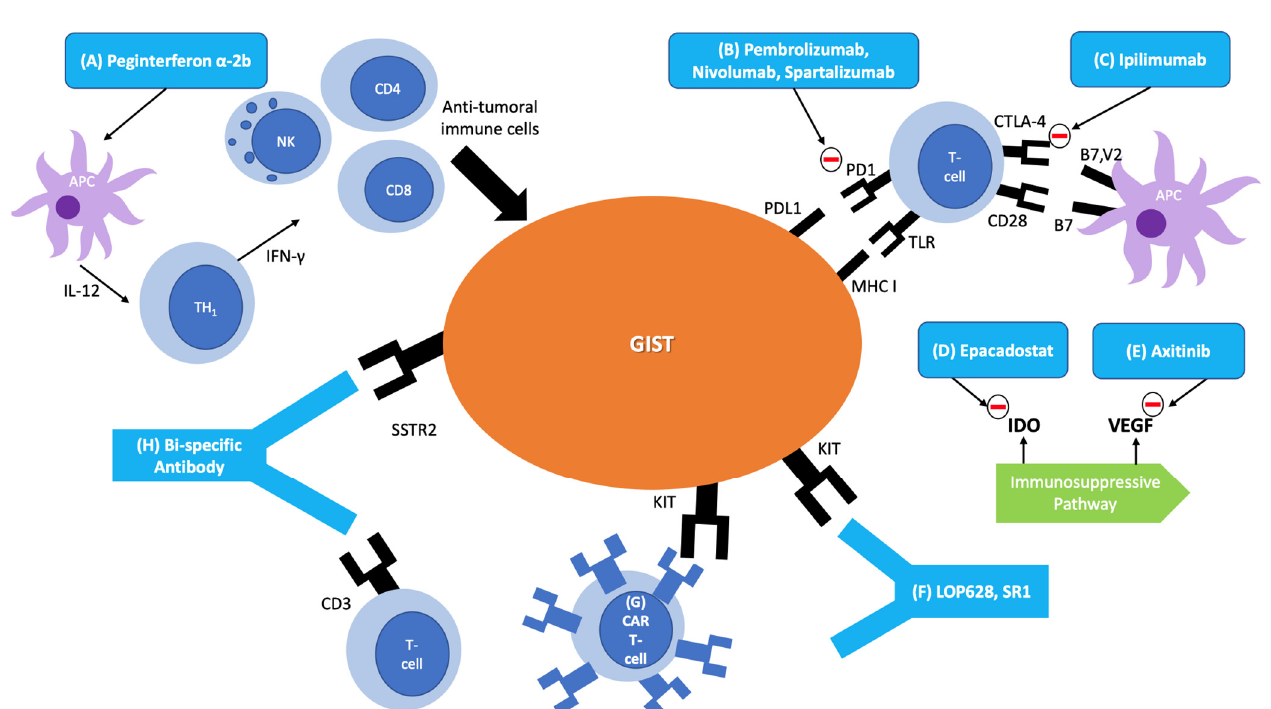
Figure 1. Immunotherapies in GIST. ( A ) Cytokine Therapy: Peginterferon alpha-2b is a cytokine-based therapy that is used in combination with imatinib to treat stage III/IV GIST. It functions by presenting an antigen cocktail to an antigen presenting cell (APC) to induce an IL-12 mediated TH1 immune response. The TH1 response secretes interferon-gamma and activates anti-tumoral immune cells. ( B – E ) Immune Checkpoint Inhibitors: ( B ) Pembrolizumab, Nivolumab, and Spartalizumab are programmed cell death protein-1 (PD1) inhibitors, preventing the PD1 and PDL1 interaction that leads to immune suppression and evasion of the immune system by cancer cells. ( C ) Ipilimumab is a CTLA-4 antibody, inhibiting the receptor’s function of sending inhibitory signals to T cells. ( D ) Epacodostat inhibits indoleamine-2,3-dioxygenase (IDO), an enzyme that decreases immune surveillance by downregulating NK and CD8 cells while upregulating T-regs. ( E ) Axitinib inhibits VEGF , thereby inhibiting the immunosuppressive function of VEGF . ( F ) Anti-KIT Antibodies: microtubule destabilizing maytansinoid (LOP628) and SR1 are monoclonal antibodies able to slow the growth of GIST via downregulation of KIT. ( G ) Cellular Therapy: Anti-KIT chimeric antigen receptor (CAR) T cells bind to GIST tumor cells leading to cell lysis. ( H ) Bi-specific monoclonal antibodies: binds to a somatostatin receptor (SSTR2) on tumor cells and CD3 to trigger a potent cytotoxic T cell response.